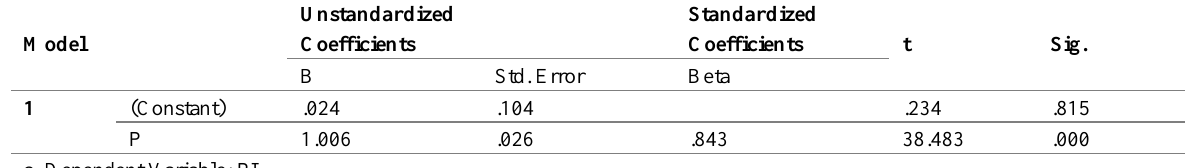
Table 16: Results of Linear Regression between Philanthropic and Purchase